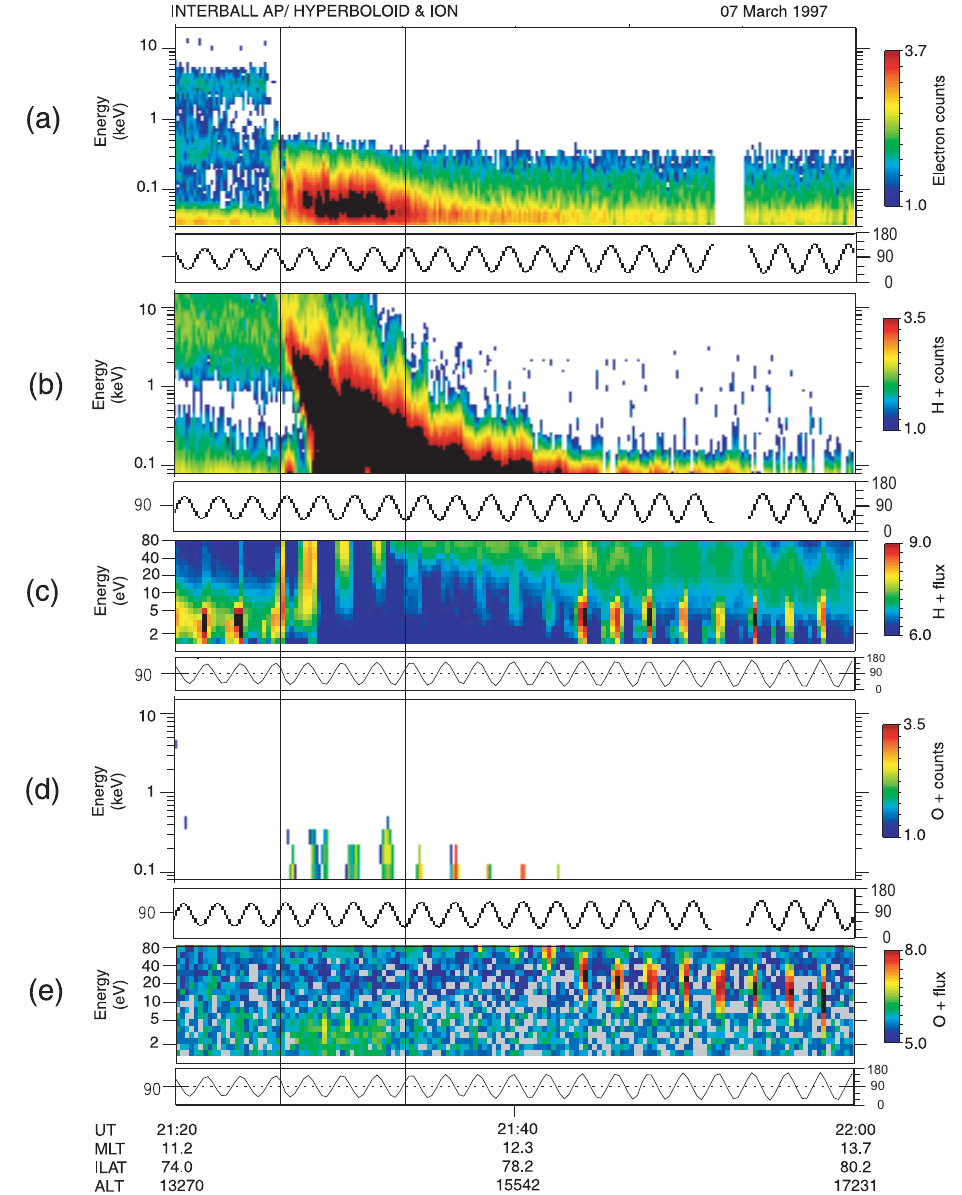
Fig. 1. Overview of a transverse ion heating event on 7 March 1997, between 21:20 and 22:00 UT. From top to bottom: energy-time spectrograms of ( a ) 30eV to 15keV electrons, ( b ) 30eV to 15keV H + ions, ( c ) 1eV to 80eV H + ions, ( d ) 30eV to 15keV O + ions, and ( e ) 1eV to 80eV O + ions. High-energy measurements in counts are from the ION experiment, while low-energy measurements in log[(m 2 ssreV) − 1 ] are measured by the central detector of the Hyperboloid experiment. The vertical black lines indicate the boundaries of the heating